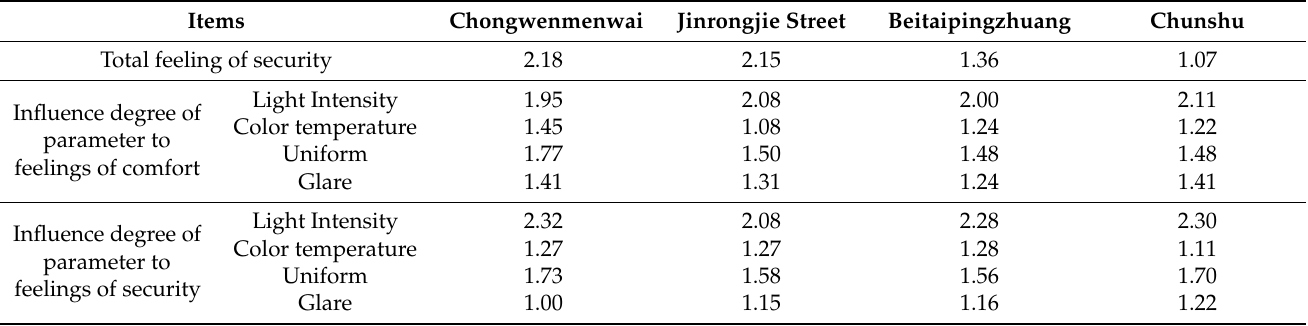
Table 2. The evaluation of influence of route lighting attributes on comfort and